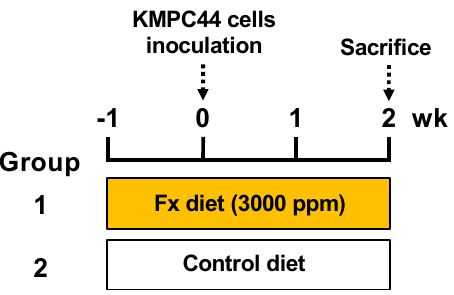
Figure 2. Experimental protocol for pancreatic cancer model mice with allogenic and orthotopic transplantations of KMPC44 cells. Fx diet (0.3% Fx) was given to group 1 ad libitum for 3 weeks before sacrifice (orange paint). The control mice (group 2) were given a control diet (Fx-free) (white paint).